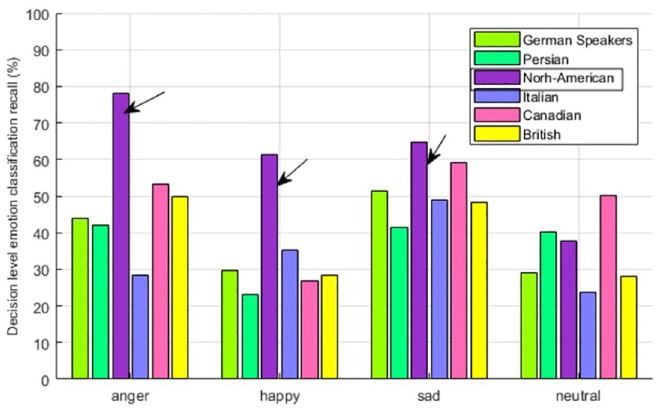
Fig 10. North-American speaker—Multicultural emotion recall comparison and In-group advantage.